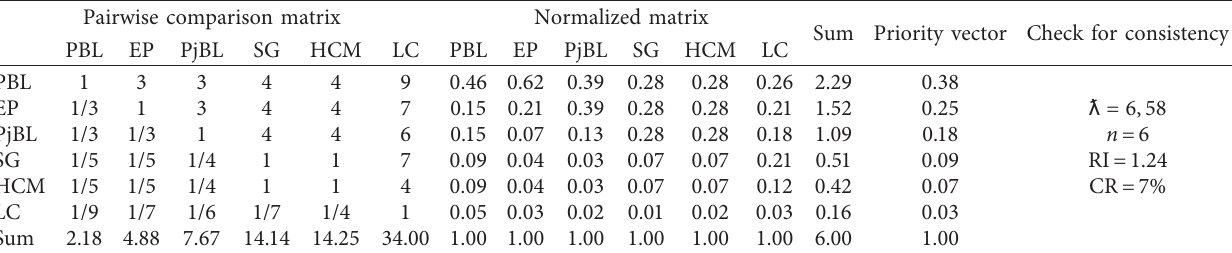
Table 18: Pairwise comparison matrix of learning strategies with respect to the Criterion “SS10. Problem resolution (analyze, synthesis).” Pairwise comparison matrix